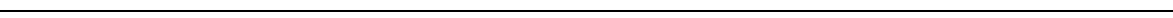
Fig. 5 VEGF-induced shape change is accompanied by dephosphorylation of myosin II light chain at the junction. a LSM of VE-cadherin and VEGFR2 in HUVECs treated with 50 ng ml − 1 VEGF or PBS. VEGF-induced invaginations (arrows) were mostly found in cells with high VEGFR2 intensity (stars) but not in less VEGFR2-expressing cells (crosses). b SIM of VE-cadherin- and Phalloidin-TRITC-labelled HUVECs after VEGF demonstrates that VE-cadherin invaginations largely co-localise with actin fi laments (arrows). VE-cadherin and actin at cell junctions (arrowheads). c LSM of phospho (ser19)-myosin II light chain (P-ser-MII-LC) and VE-cadherin in P6 mice retina. P-ser-MII-LC was largely seen in the junction of centre vein but not in front ECs. d HUVECs treated with 50 ng ml − 1 VEGF and 10 µ M Y27632, respectively, were immune labelled with P-ser-MII-LC and Phalloidin-TRITC. VEGF induced a partial loss of P-ser-MII-LC at junctions accompanied by a partial loss of JAAF (arrowhead) and wave-like junction remodelling. Stress fi bres (open arrowheads) were P-ser-MII-LC positive. Arrows indicates intact JAAF. Y27632 treatment caused a total loss of P-ser-MII-LC and also induced wave-like junction remodelling. Quanti fi cation of e number ( n = 411 VE-cadherin invagination for 305 cells for PBS, 815 VE-cadherin invaginations for 338 cells for VEGF) and f length of VE-cadherin invaginations in VEGF- ( n = 98 VE-cadherin invaginations) and PBS-treated ( n = 92 VE-cadherin invagination) cells. Quanti fi